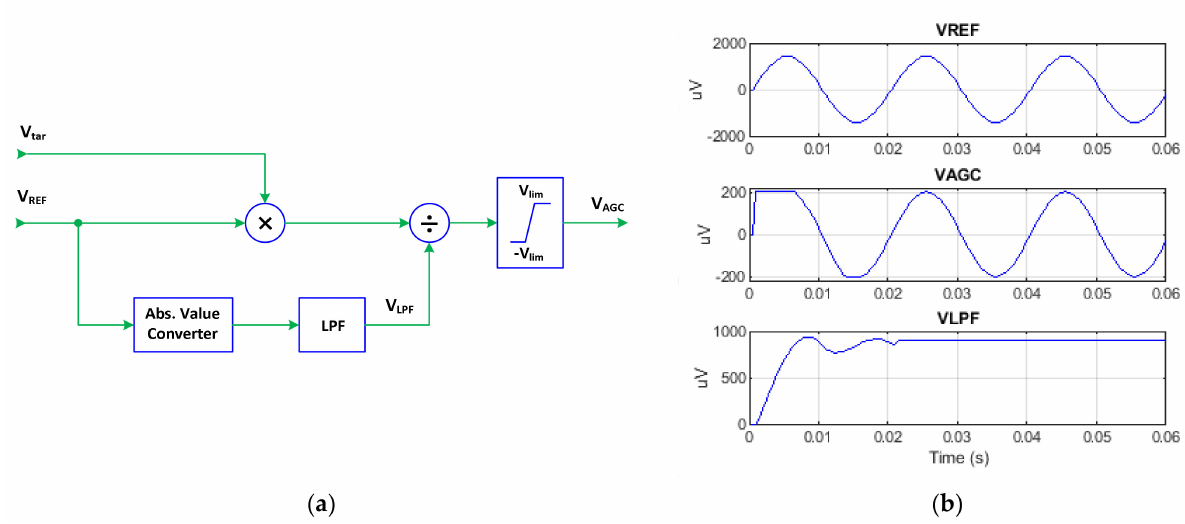
Figure 5. Open-loop automatic gain control: ( a ) architecture, ( b ) start-up